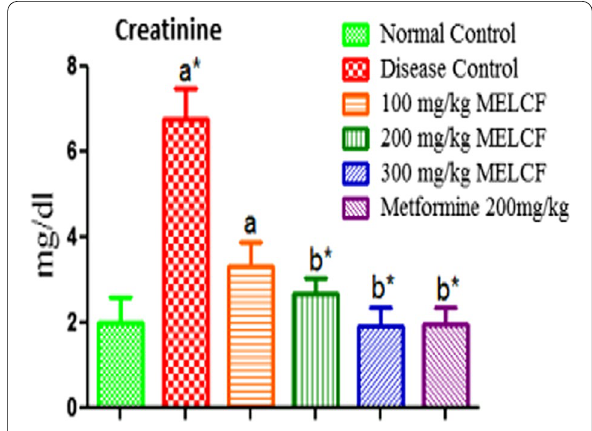
Fig. 11 Effect of MELCF on creatinine. The values represented as mean SEM ( n 6). a* ( p < 0.05) when compared to normal control ± = and b* ( p < 0.05) when compared to disease/diabetic control